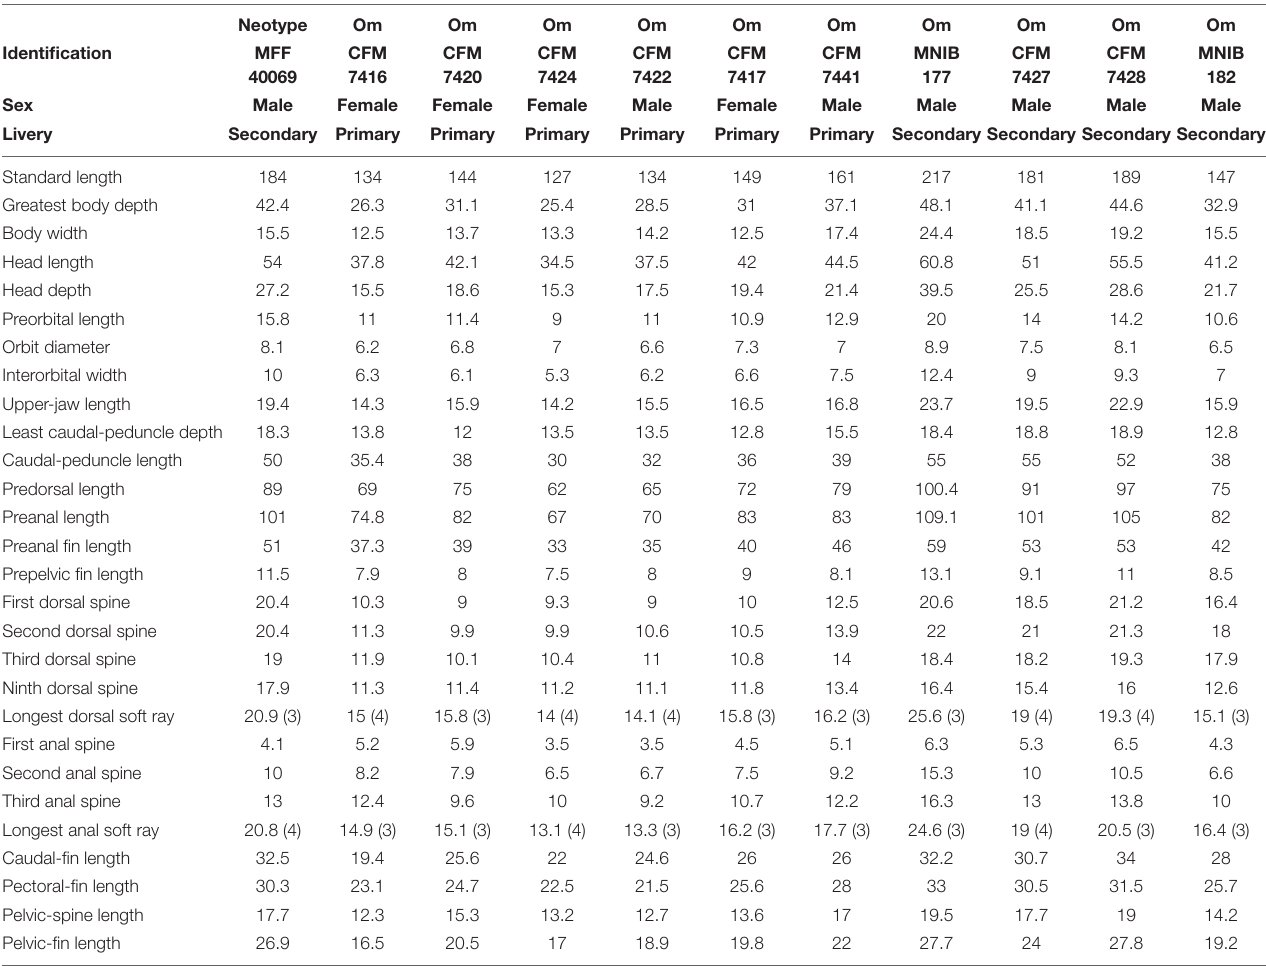
TABLE 1 | Measurements of the neotype and other material (Om) of Coris melanura